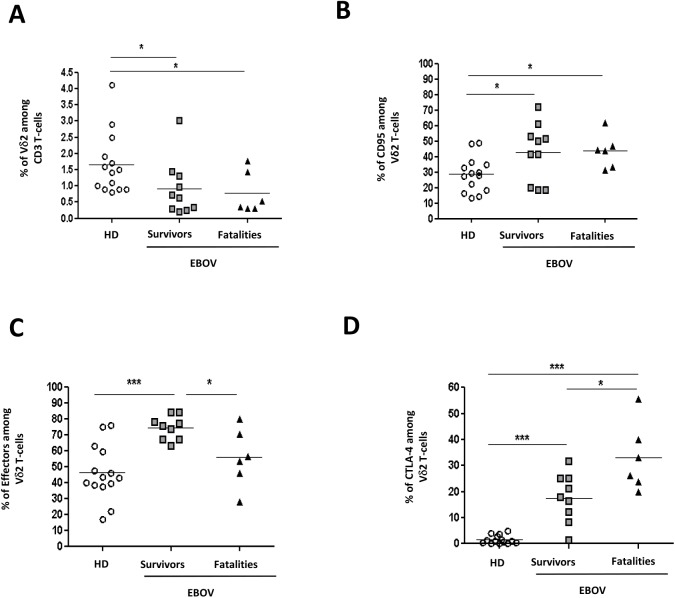
Frequency of Vδ2 T-cells in survivors and in fatalities.The frequency of Vδ2 (A), Vδ2posCD95pos (B), of Vδ2posCCR7neg (C) and Vδ2posCTLA-4pos (D) was analyzed in HD (n = 14), EBOV-survivors (n = 10) and EBOV-fatalities (n = 6). Statistical analysis was performed by using Mann Whitney test and differences were considered significant with a p<0.05 and highlighted with an asterisk.*: p<0.05; **: p<0.01; ***: p<0.001.